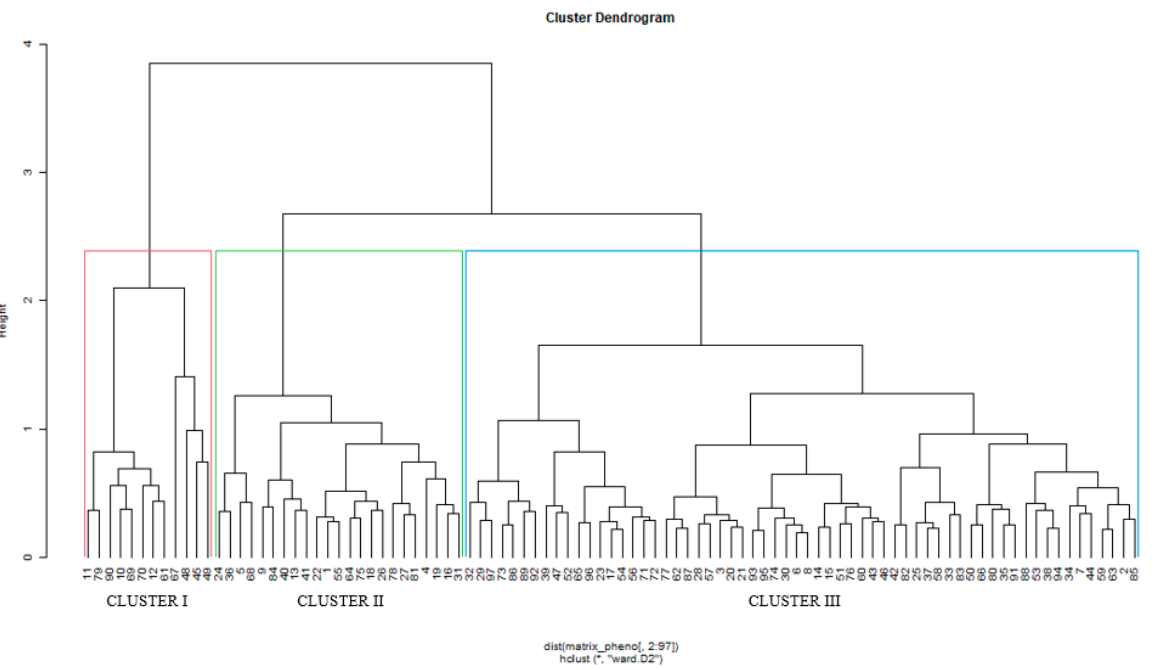
Figure 2. Hierarchical clustering of 97 wheat genotypes based on phenotypic traits measured under drought-stressed conditions. Clusters are separated by color lines.